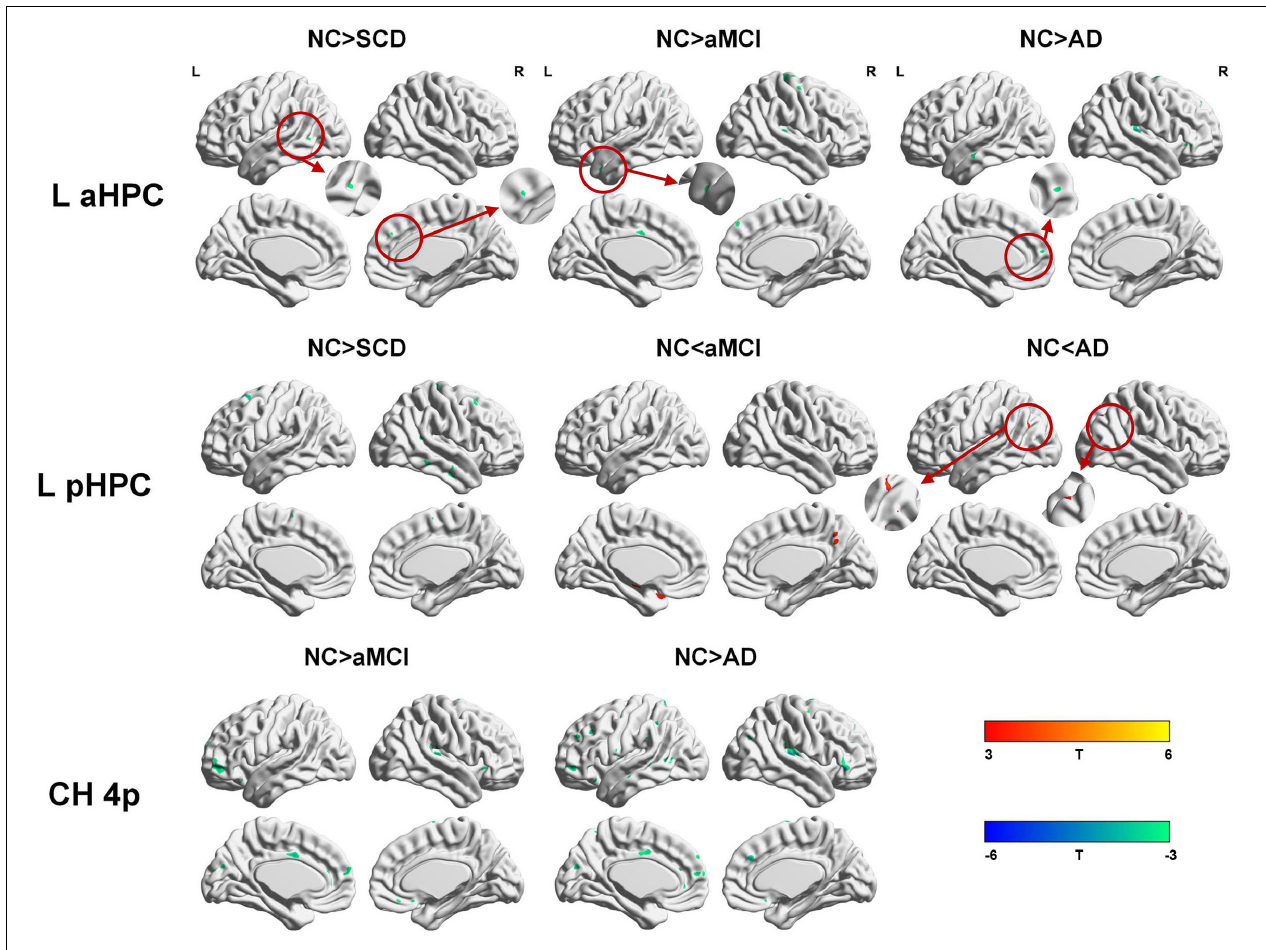
FIGURE 5 | Between-group (NC-SCD; NC-aMCI; and NC-AD) differences in structural covariance networks seeding from the left anterior and posterior hippocampus and Ch4p. T-statistic maps, p < 0.01 at the voxel level and p < 0.05 at the cluster level, two-tailed GRF correction with cluster size larger than 100 voxels. The small clusters are circled by the red circles, and they are enlarged. L, left; R, right; aHPC, anterior hippocampus; pHPC, posterior hippocampus; AD, Alzheimer’s disease; NC, normal control; aMCI, amnestic mild cognitive impairment; SCD, subjective cognitive